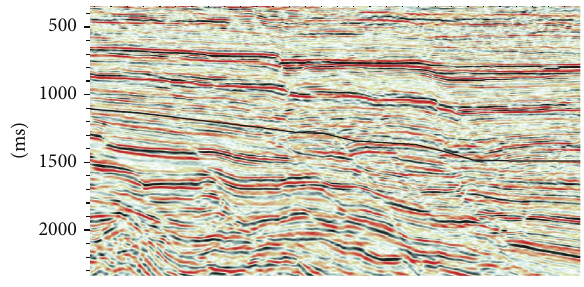
Figure 2: The target layer in black lines.